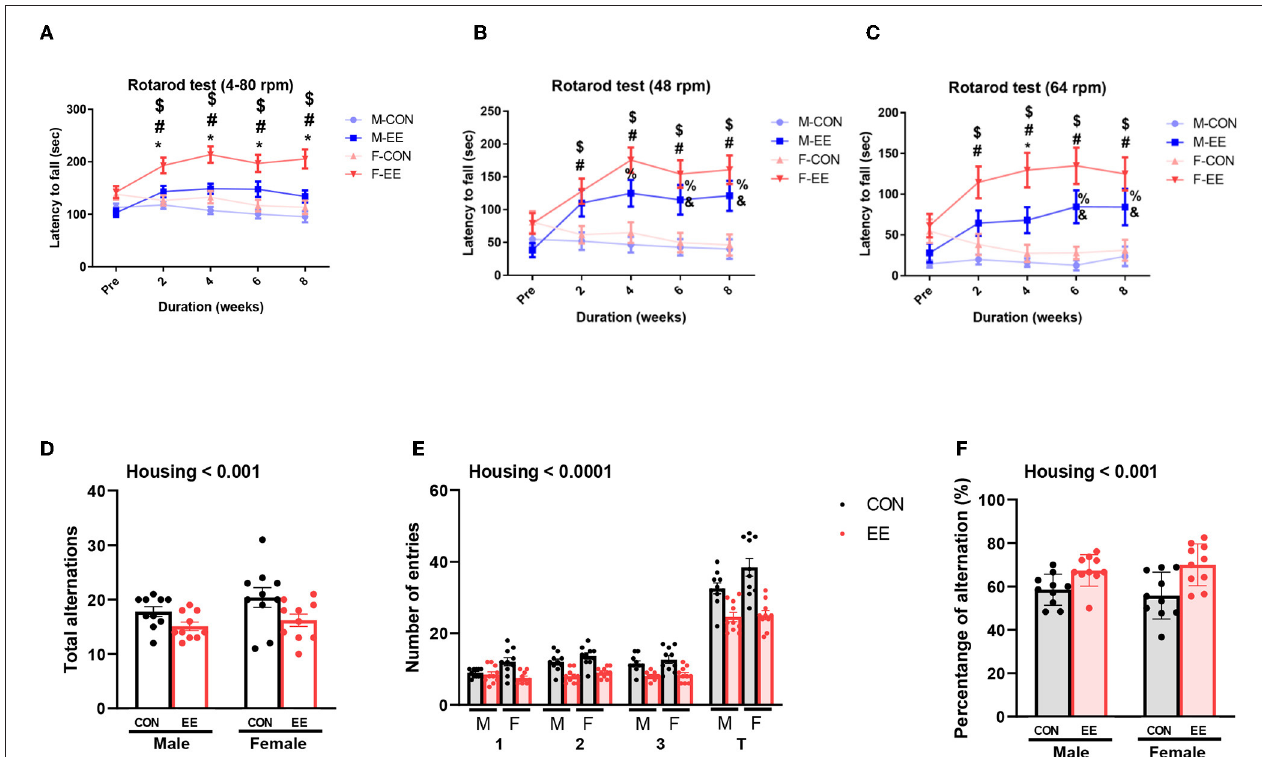
FIGURE 6 | Effects of EE on functional improvement in normal models. Behavioral test assessments conducted for the normal groups. (A) Rotarod accelerating from 4 to 80 rpm. (B) Rotarod at constant 48 rpm. (C) Rotarod at constant 64 rpm ( n = 26 per group). *F-EE vs. M-EE, # F-EE vs. F-CON, $ F-EE vs. M-CON, % M-EE vs. M-CON, and & M-EE vs. F-CON. (D) Number of alternative behaviors, (E) number of entries, and (F) percent alternation of Y-maze test ( n = 10 per group). Two-way ANOVA with Tukey multiple comparison test. Significant sex effect, significant housing effect, and the significant interaction between sex and housing were noted with p -value. Data represented are means ± SEM. * p < 0.01, # p < 0.01, $ p < 0.01, % p < 0.01, and & p <